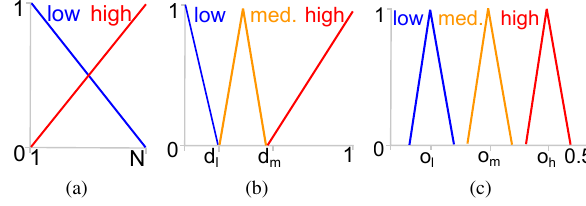
Figure 8: Fuzzy membership functions of (a) fitness ranks (N - population size) (b) population diversity, (c) output